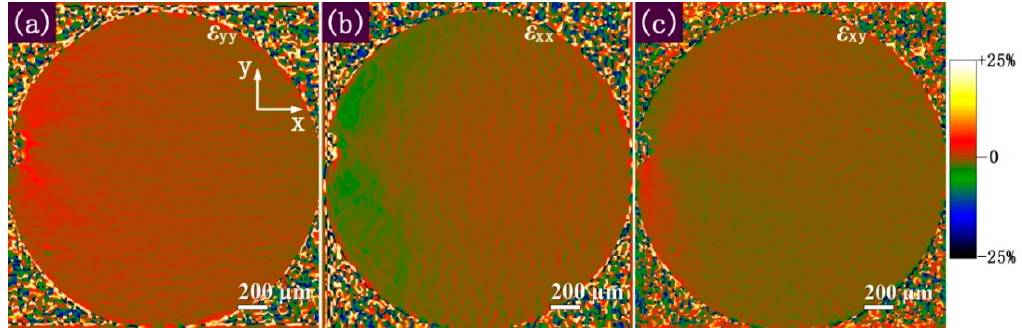
Figure 5. Strain fields at 200 N during the increasing load corresponding to Figure 3c measured by using the GPA method: ( a ) ε yy strain field; ( b ) ε xx strain field; ( c ) ε xy strain field.